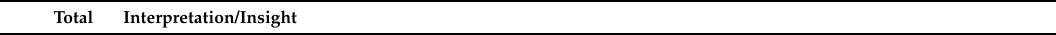
Table 1. FCM results (network